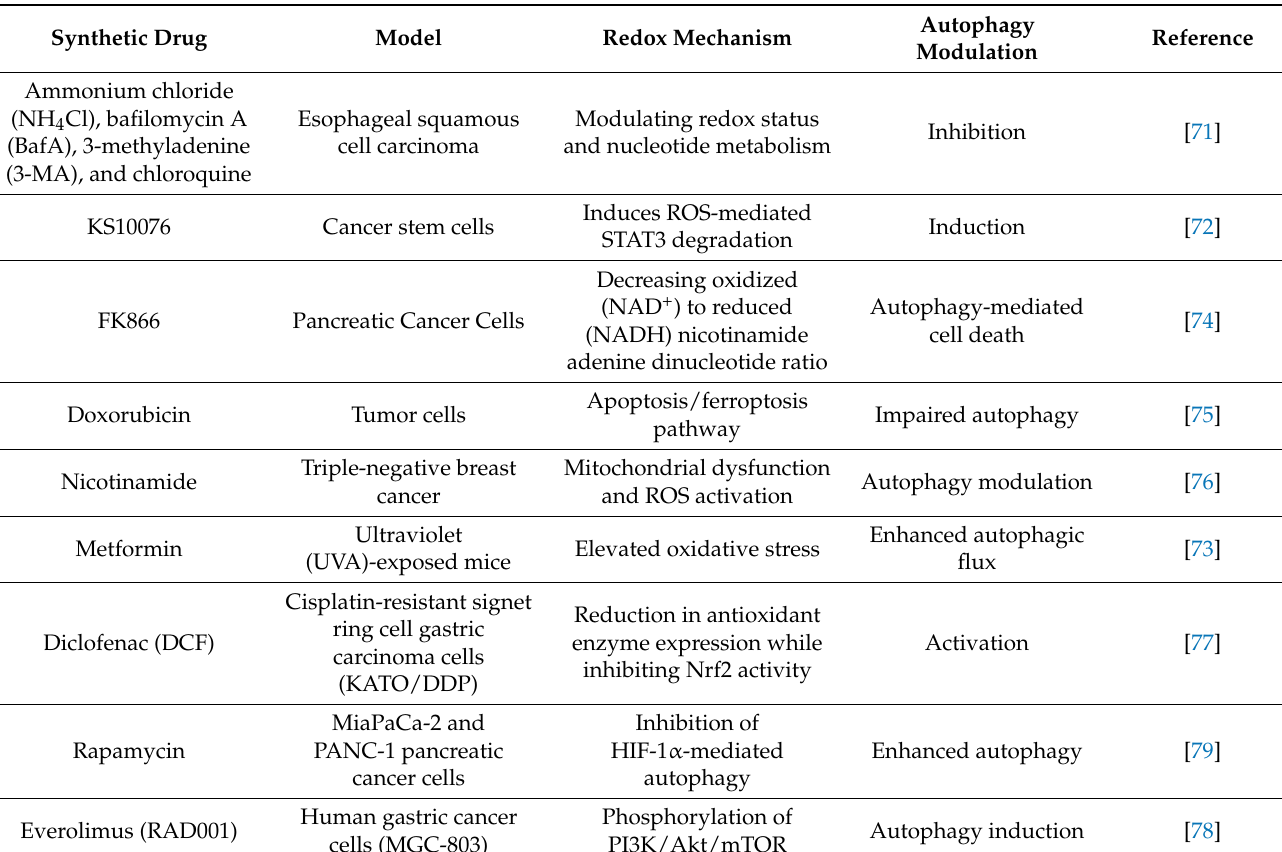
Table 1. Synthetic drugs that were recently used to maintain redox homeostasis via autophagy- mediated signaling in several cancer